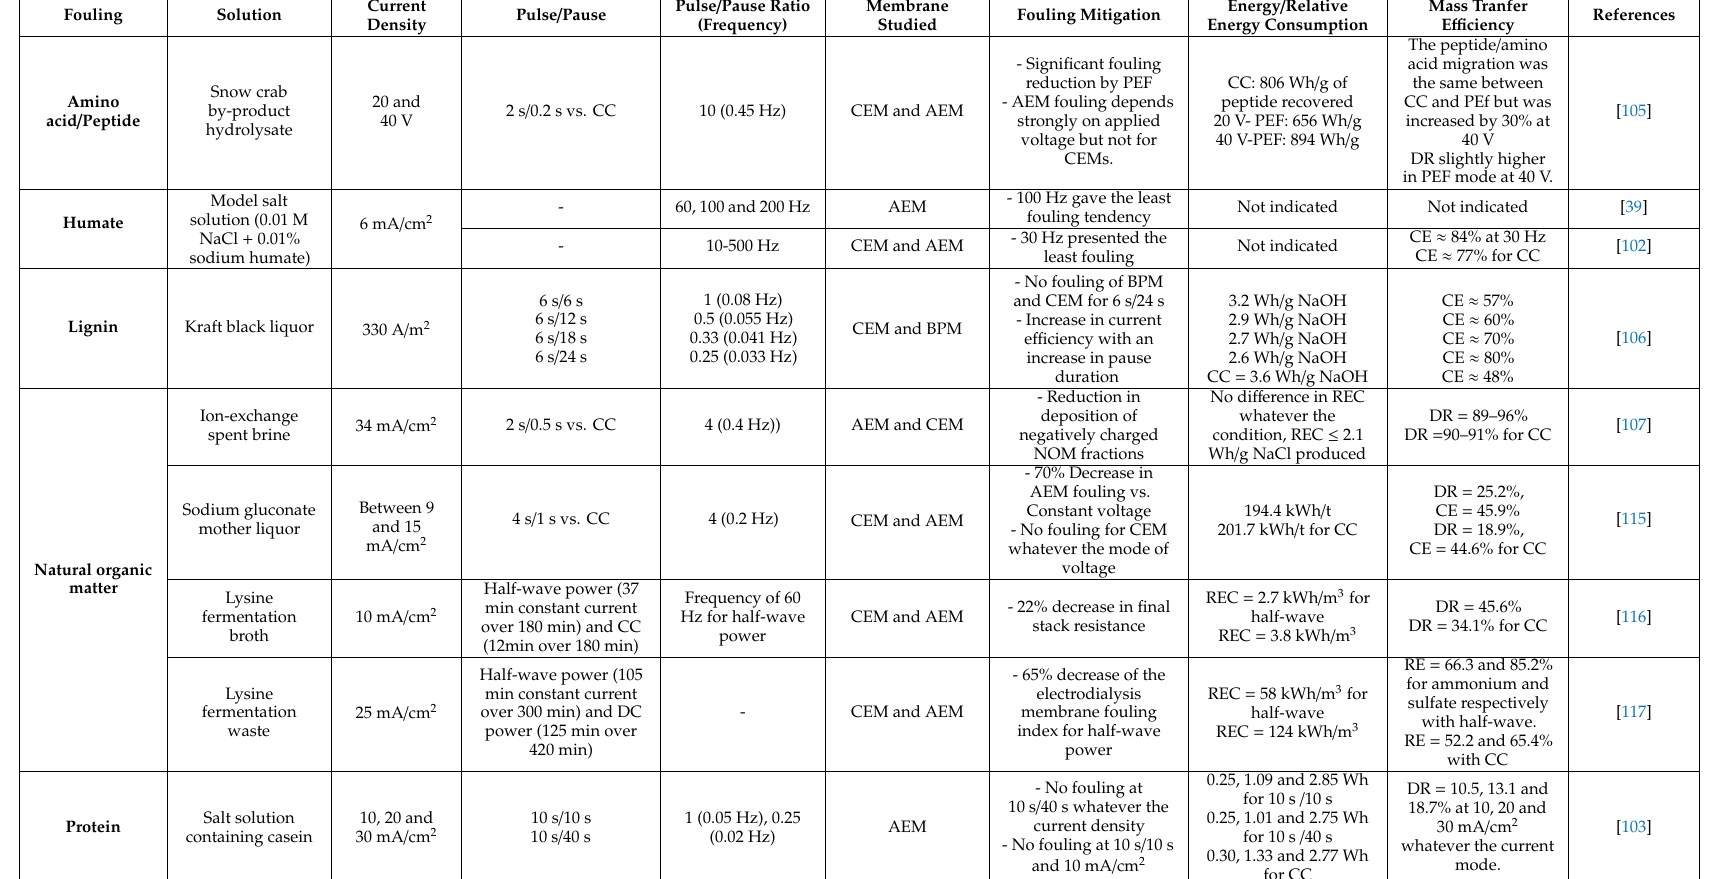
Table 1. Mitigation of di ff erent fouling natures during electrodialysis, of model and complex solutions, under pulsed electric field regimes and impact on